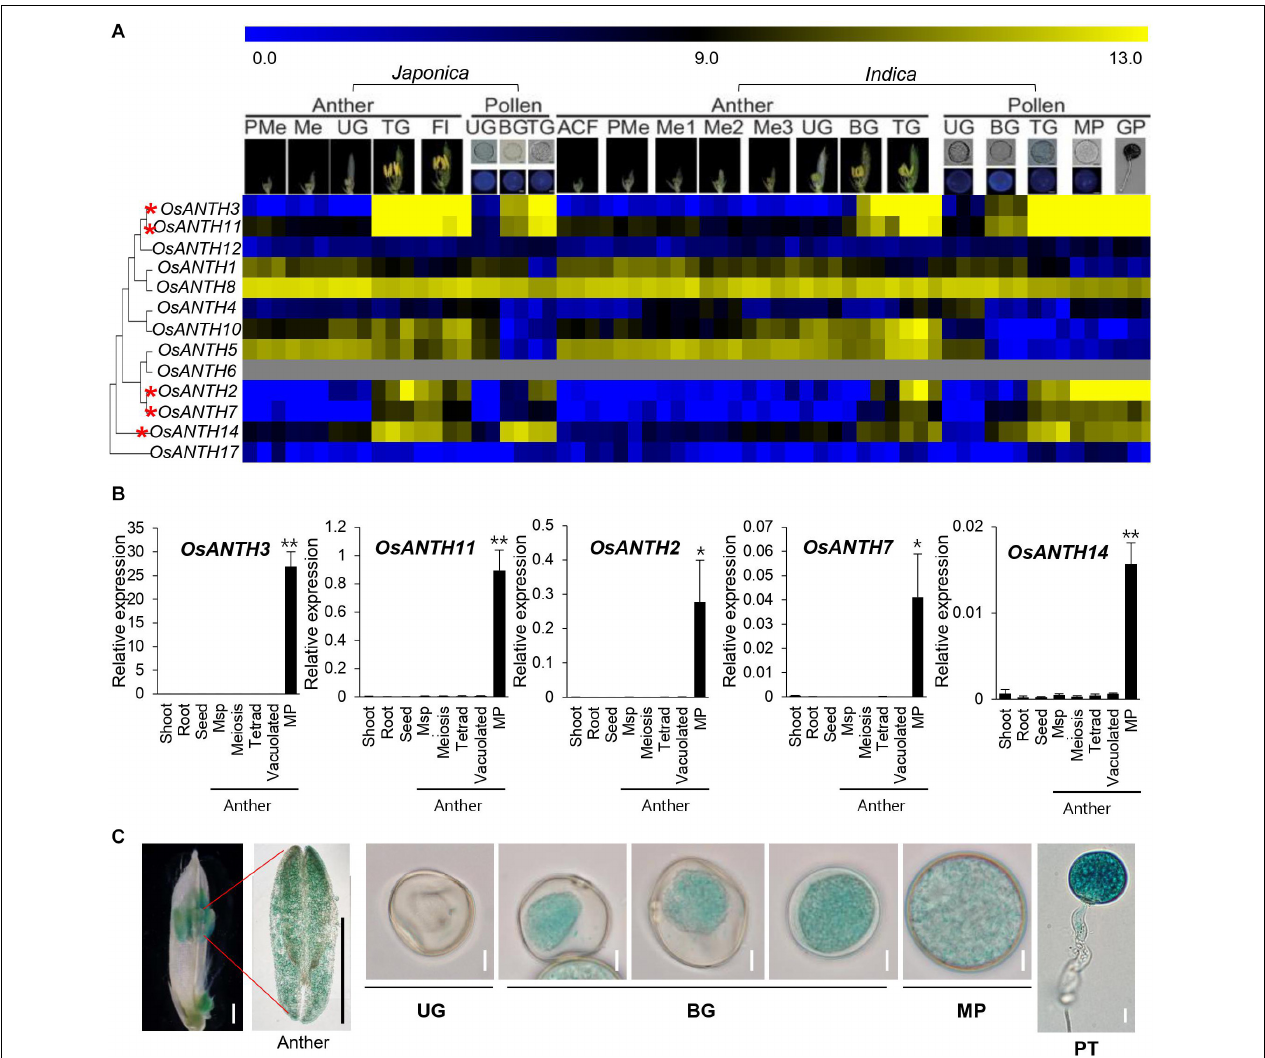
FIGURE 3 | Expression patterns of OsANTH genes in rice. (A) Heatmap showing expression levels as determined by microarray analysis. Yellow color in the heatmap indicates a high level of expression, whereas dark blue indicates low expression. Numeric values indicate an average of the normalized log 2 intensity value of the microarray data. Pollen-preferentially expressed OsANTH genes are indicated by red asterisks. ACF, archesporial cell-forming stage; BG, bi-cellular gametophyte stage; Fl, flowering stage; GP, germinated pollen; Me, meiotic stage; Me1, meiotic leptotene stage; Me2, meiotic zygotene-pachytene stage; Me3, meiotic diplotene-tetrad stage; MP, mature pollen stage; PMe, pre-meiosis; TG, tricellular pollen stage; UG, uni-cellular gametophyte stage. (B) Expression of pollen-preferred ANTH domain-containing protein-coding genes in Oryza sativa ( OsANTH genes) analyzed via qPCR in various tissues of rice. Msp, Microspore; MP, mature pollen. Rice ubiquitin 5 ( OsUbi5 , LOC_Os01g22490 ) was used as an internal control. The y -axis shows the expression level relative to OsUbi5 , while the x -axis shows the samples used for analyses. Error bars represent the standard errors of three biological replicates. Significant differences are indicated by asterisks; * p < 0.01 and ** p < 0.0001. Data were analyzed by employing one-way analysis of variance with repeated measures using Tukey’s pairwise comparison test. (C) Expression pattern of OsANTH3-GUS in transgenic rice plants at the anther and sequential stages of pollen development. UG, unicellular gametophyte stage; BG, bicellular gametophyte stage; MP, mature pollen stage. Bar in flower and anther image = 1 mm; bar in pollen image = 10 µ m.